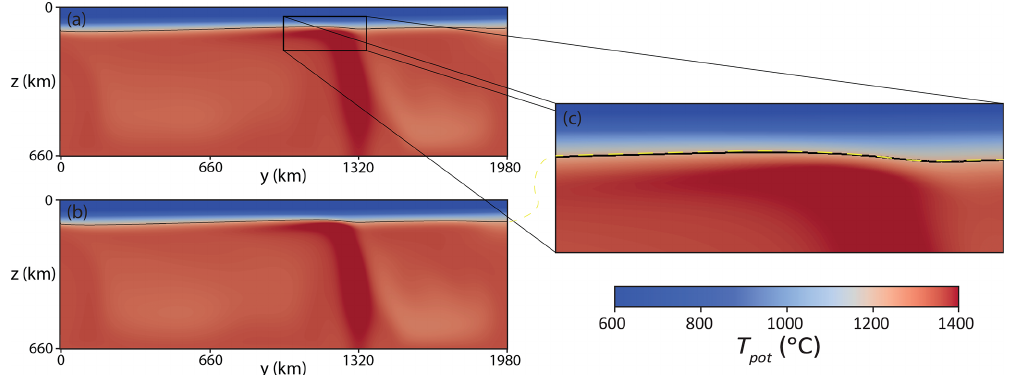
Figure A4. Vertical cross sections parallel to the edge (perpendicular to the x direction) and x = 1254km. The isotherm of T pot = 1215 ◦ C is drawn as a black line. (a) Reference case. (b) Case with (cid:49)T = 200 ◦ C and other values as in the reference case. (c) Closeup of the reference case with the isotherm of the case depicted in (d) (dashed yellow line). Note that due to plume deflection, the x coordinate for maximum lithospheric erosion does not correspond to the location of the thermal anomaly at the